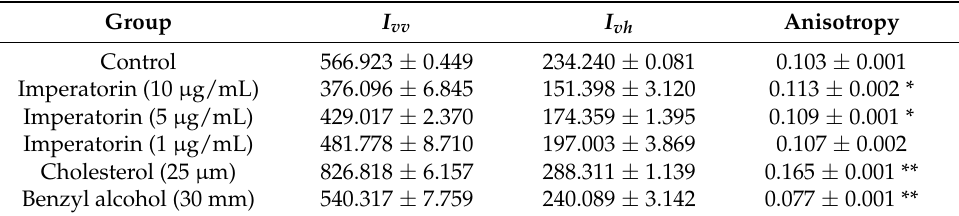
Table 2. Effect of imperatorin on membrane fluidity (x ± sd, n = 4).